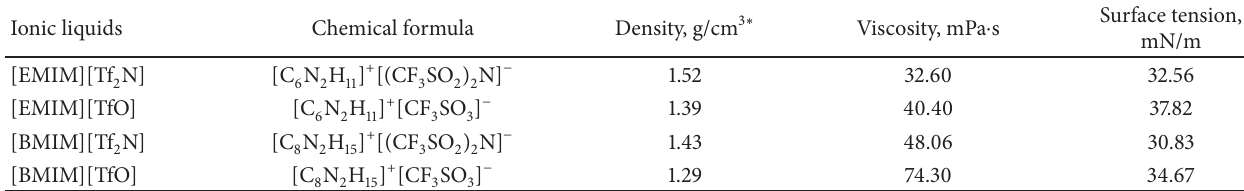
Table 3: Physicochemical properties of ionic liquids used in the experiments at 298